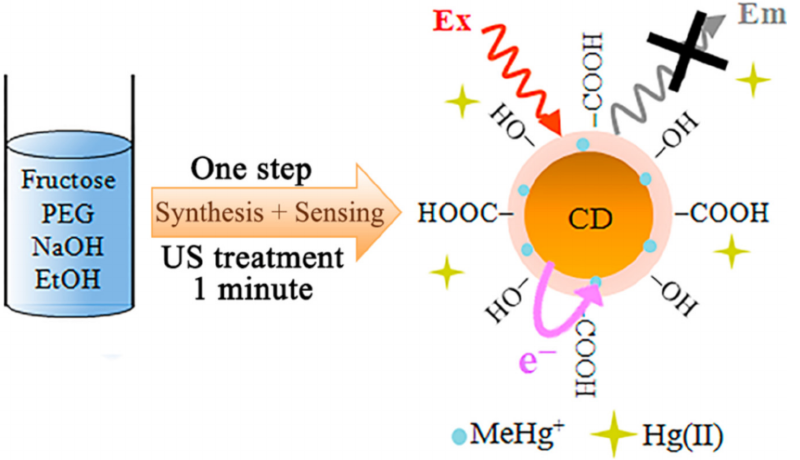
Figure 8. Graphical representation of preparing fluorescent carbon dots on a modified electrode to determine methylmercury. Reprinted (adapted) with permission from [72]. Copyright 2014, Elsevier.